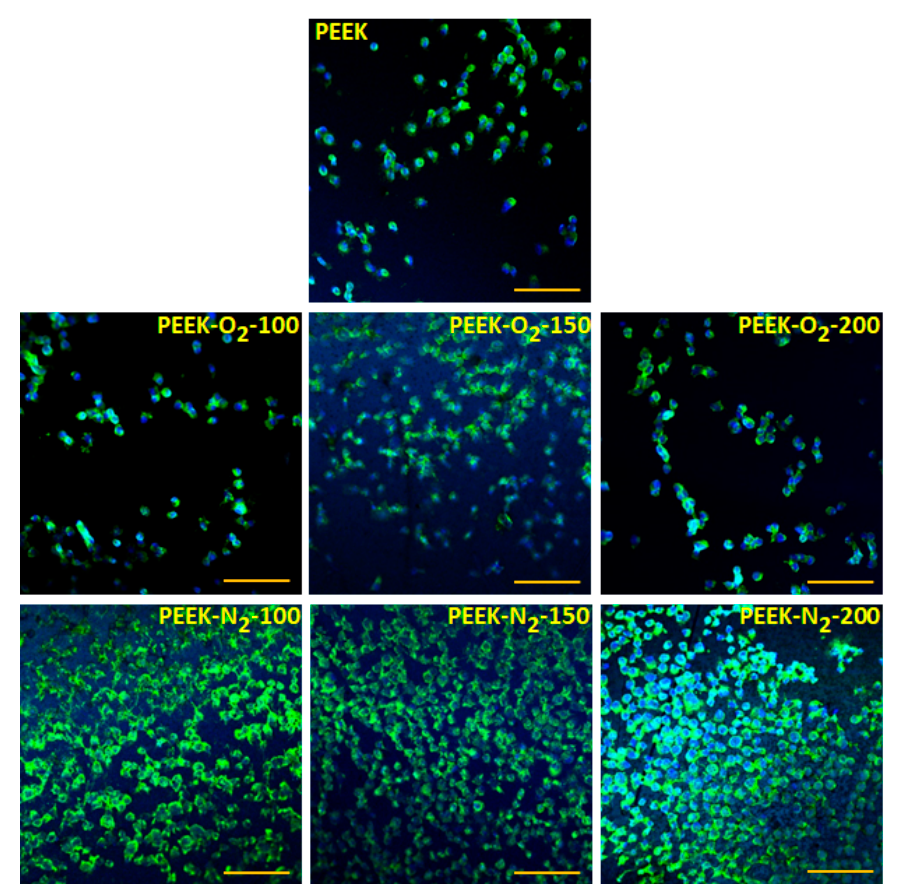
Figure 10. MG63 adhesion to the analyzed materials after 24 h of culture. Scale bar: 100 µm. Blue staining—nucleus (DAPI), green staining—actin (AlexaPhalloidin 488).